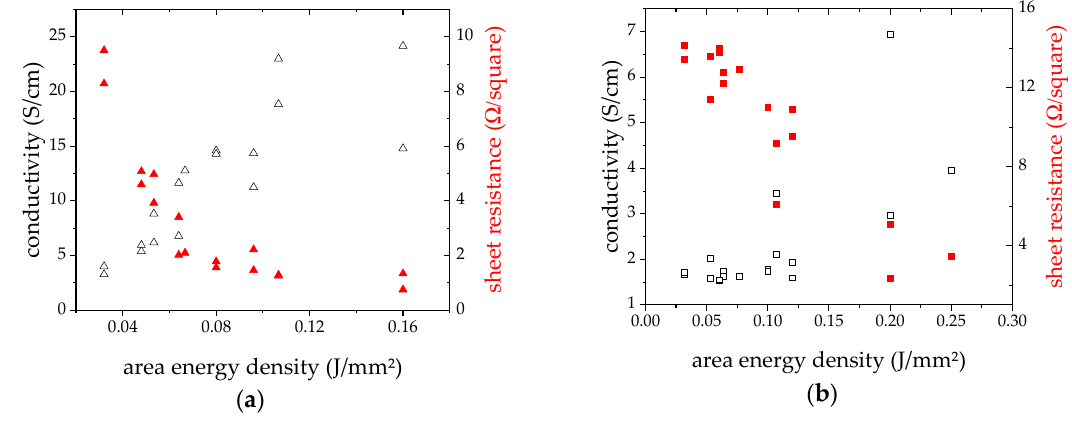
Figure 5. Sheet resistance and conductivity vs. E sq. , ( a ) p-type; ( b ) n-type (empty symbols correlated to conductivity, red filled symbols to sheet resistance).